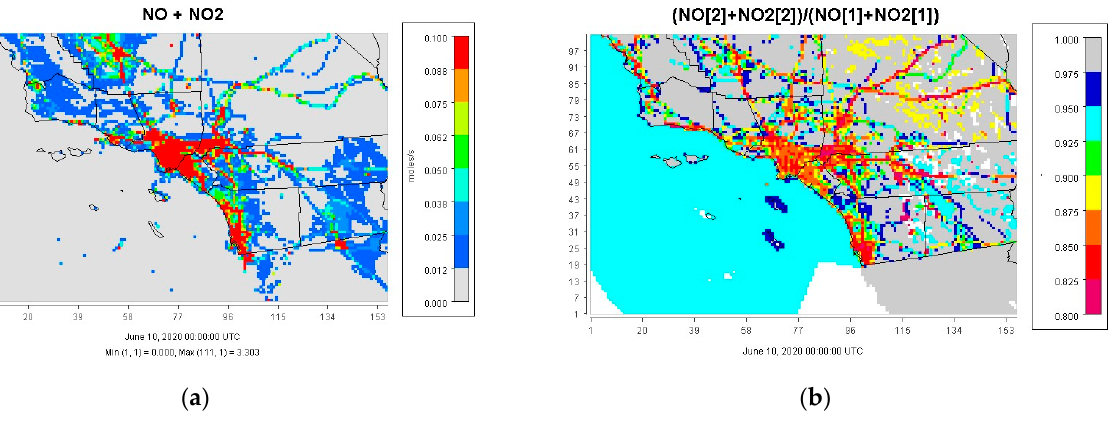
Figure 4. Example of model-ready NOx emissions on the 4-km domain: ( a ) 2020 BAU NOx emissions; ( b ) 2020 BAU/2020 COVID NOx emissions.